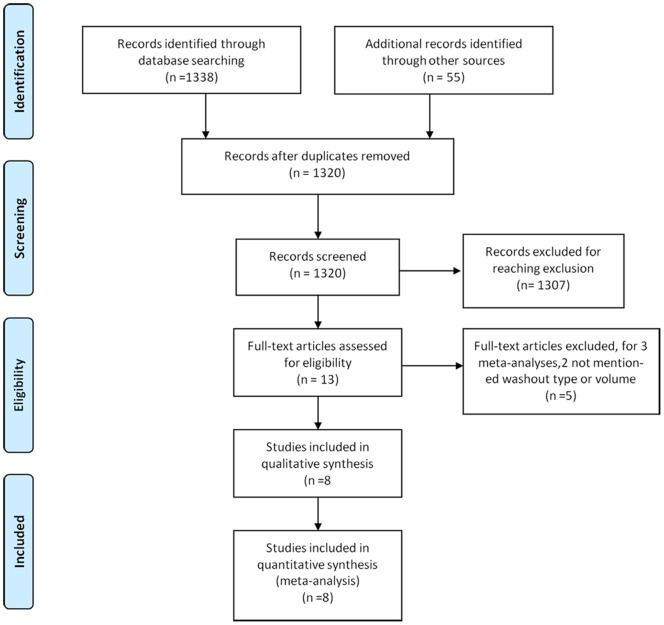
Flow diagram of study selection.